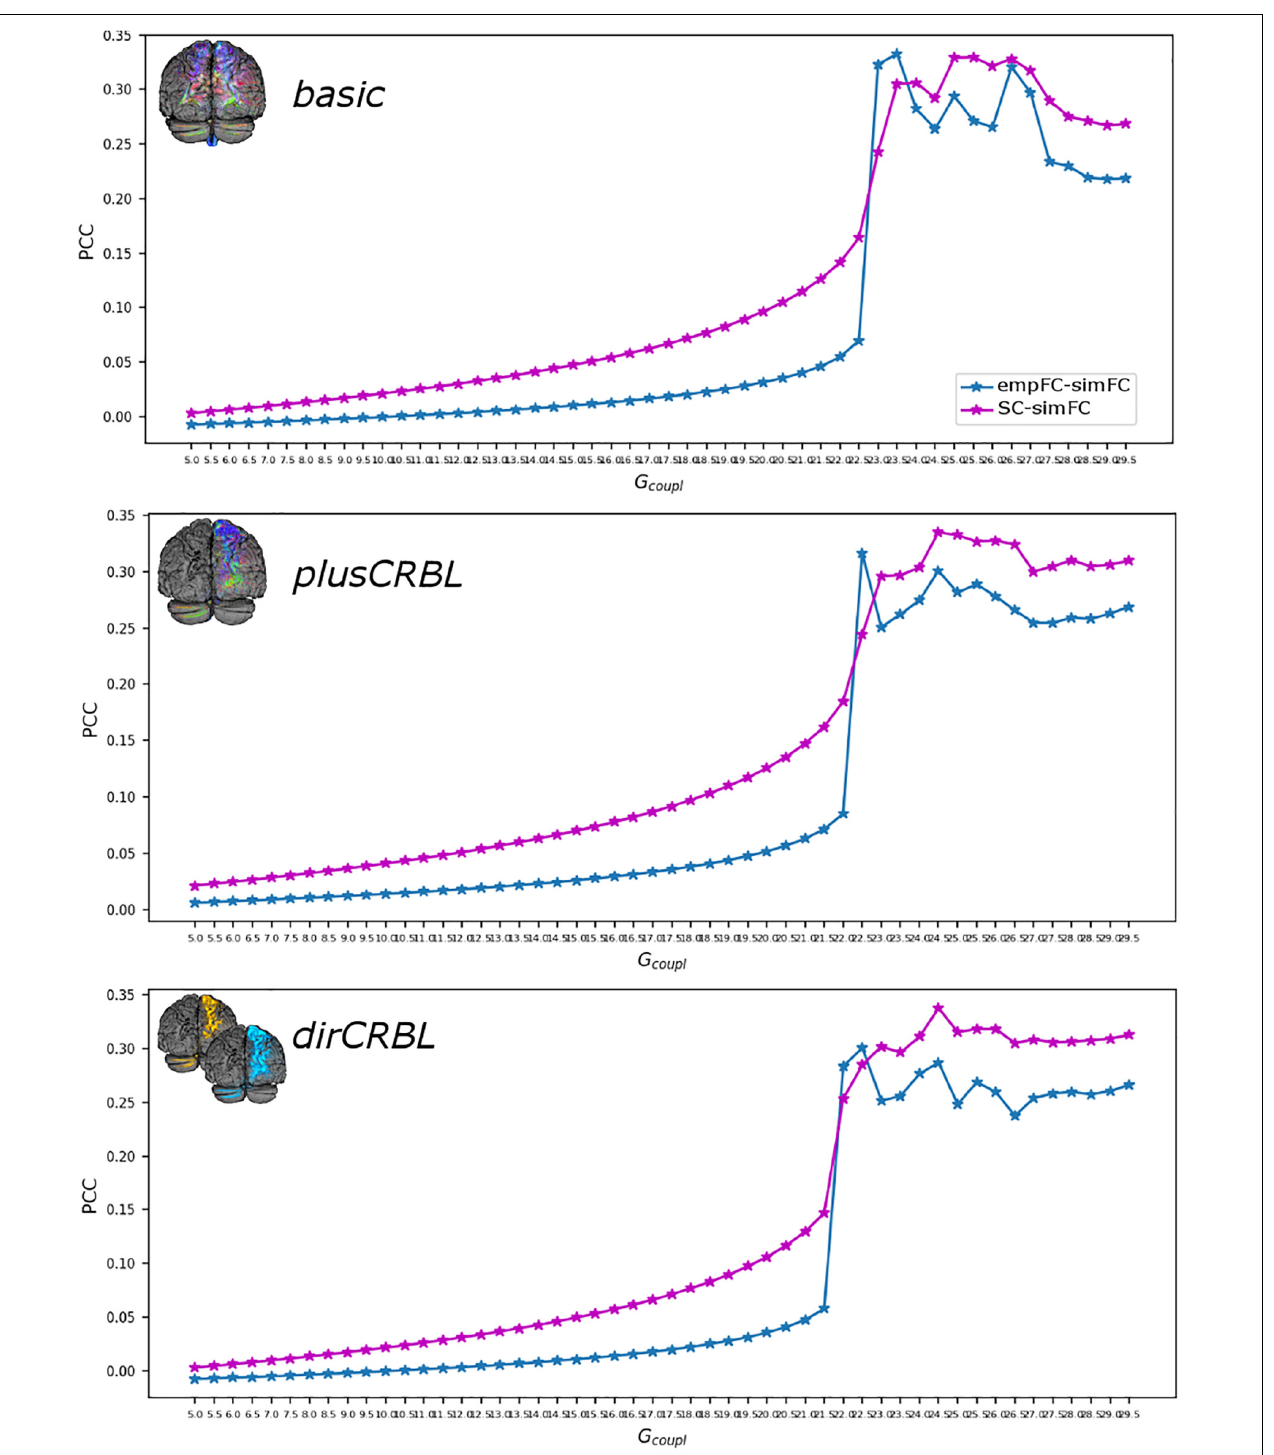
FIGURE 4 | Correlation diagram between empirical and simulated data as a function of the global coupling parameter (G coupl ). The data are taken from a randomly chosen subject for each SC construct (top to bottom: basic, plusCRBL, dirCRBL ). The correlation between structural and simulated FC is shown with magenta line, while correlation between empirical FC and simulated FC is shown with blue